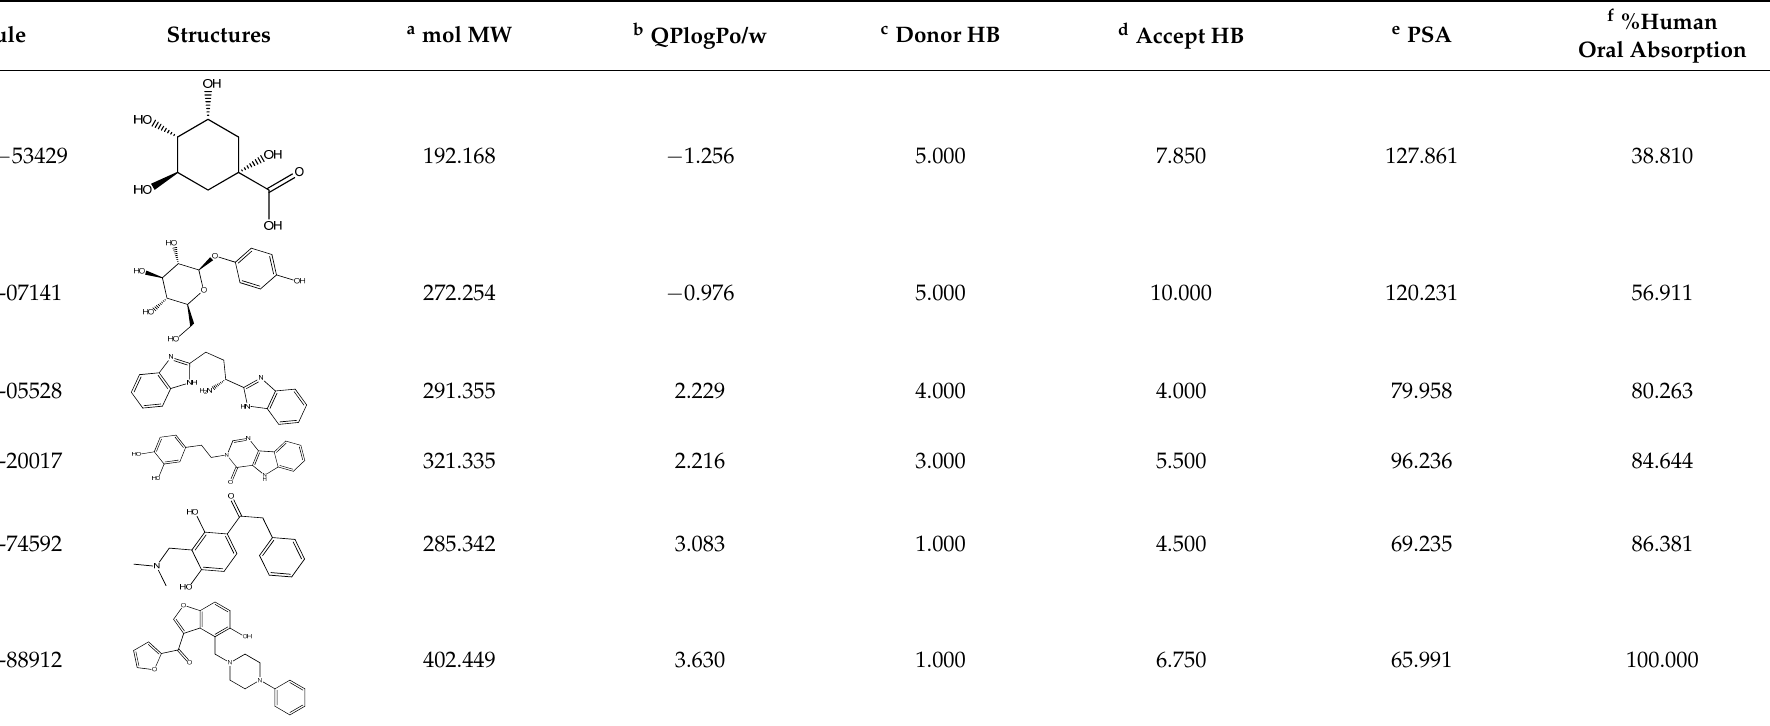
Figure 2. The interactions between the receptor and the 12 top ligands. The yellow line shows a hydrogen bond, the blue lines show π - π interactions, and the green lines show salt bridges.